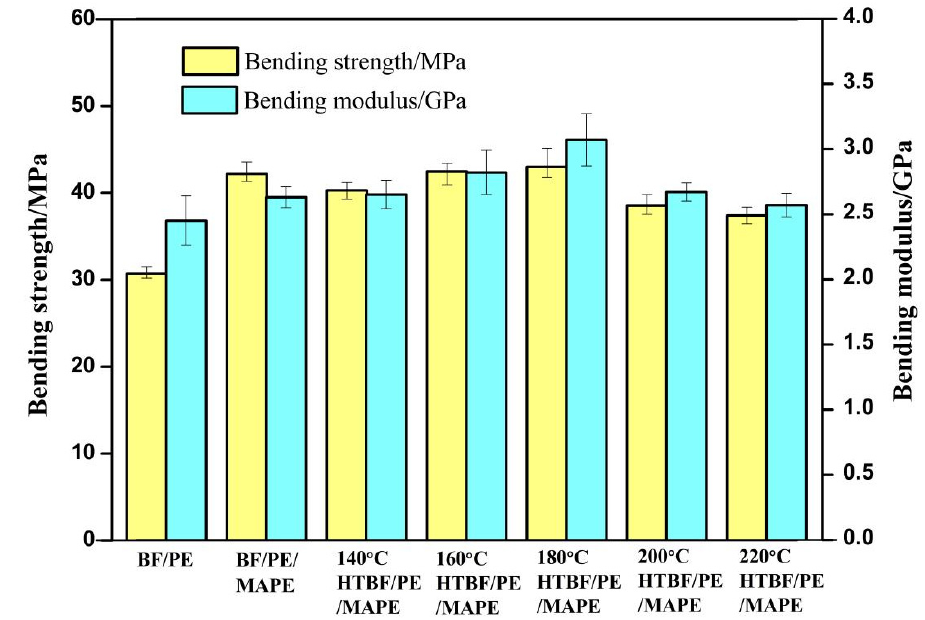
Figure 8. Bending strength and bending modulus of bamboo plastic composites.